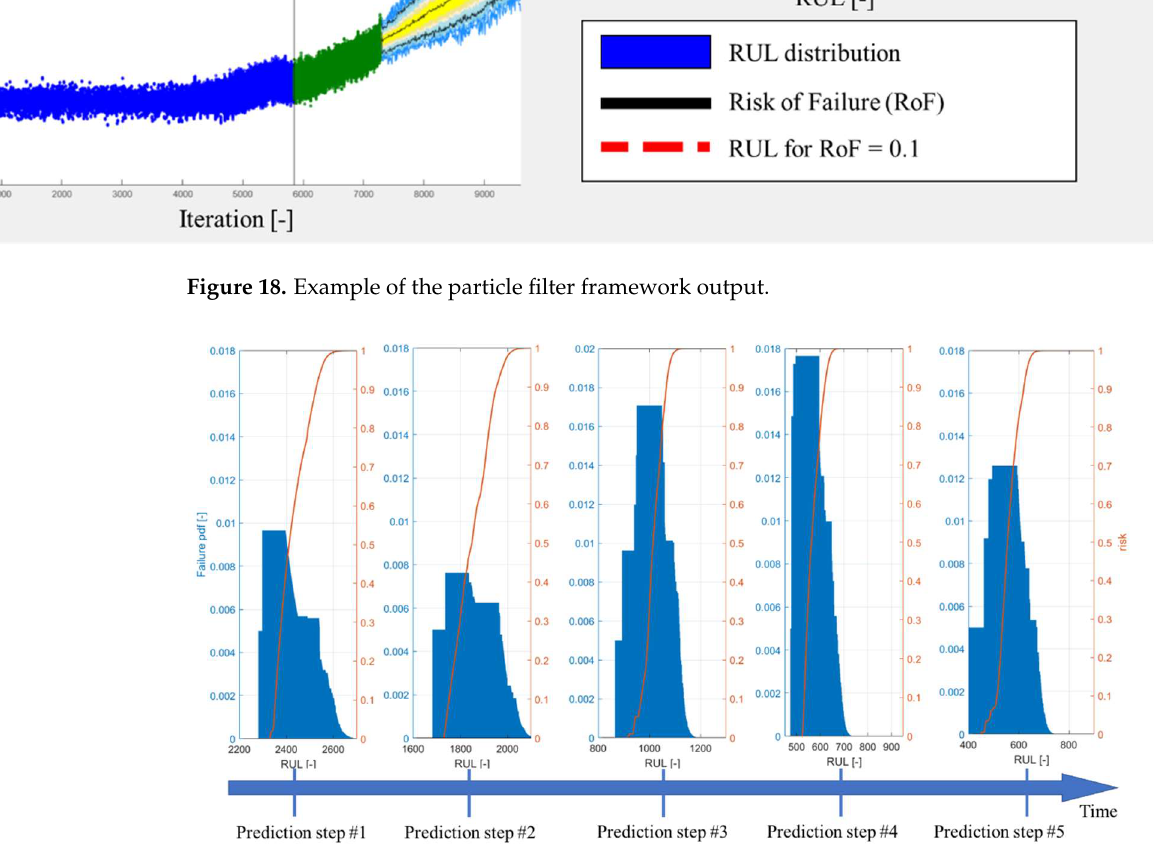
Figure 19. Example of RUL estimate for 5 consequent prediction steps for one of the degradation patterns associated with the demagnetization of the motor permanent